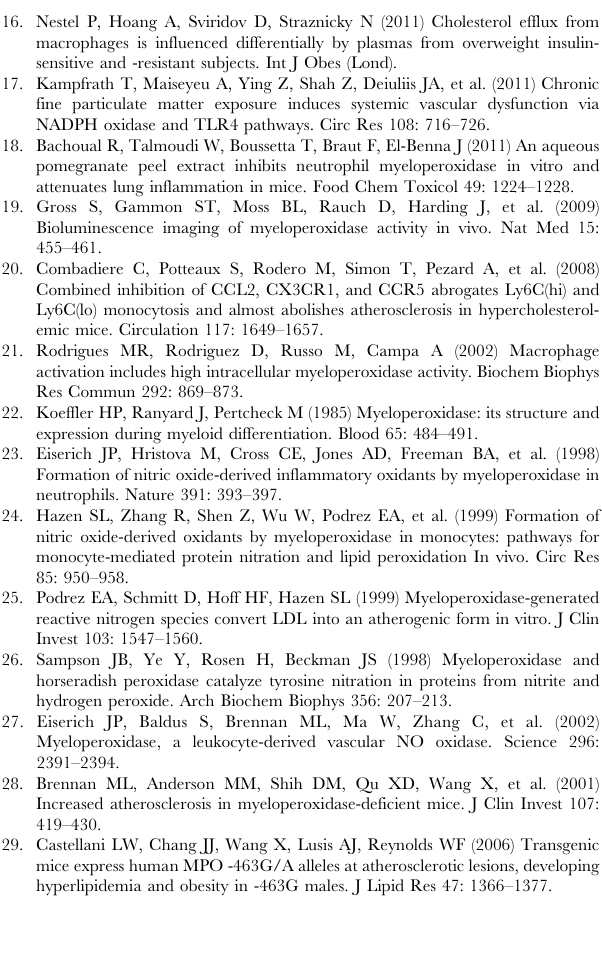
Figure S5 Effects of MPO inhibition on pro-inflamma- tory gene expression in different tissues from ApoE 2 / 2 mice fed a